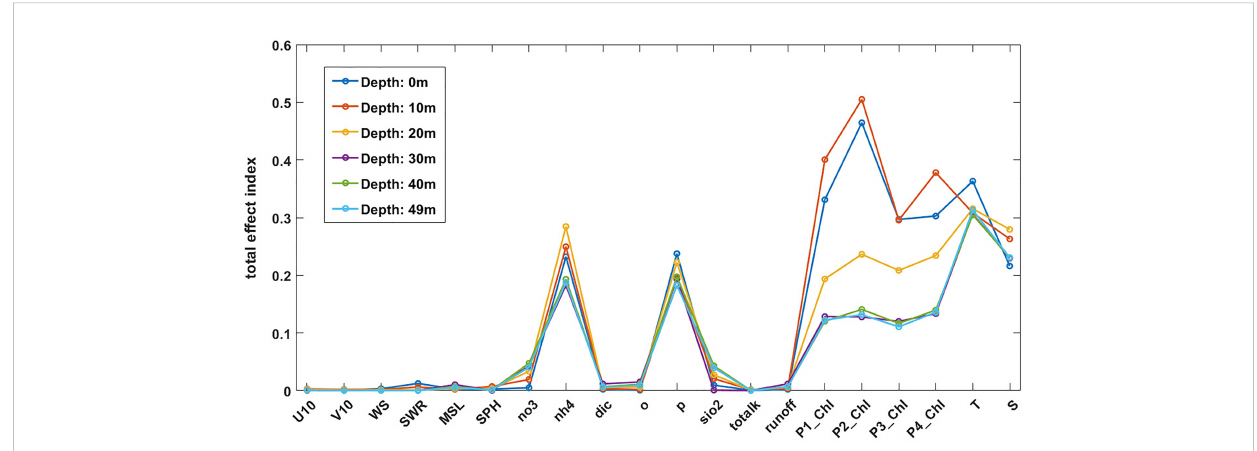
FIGURE 8 Total effect indexes for the full range of ML model inputs from the MinSc case at the L4 location. The abbreviations are: “ U10 ” : zonal wind at 10m, “ V10 ” : meridional wind at 10m, “ WS ” : total wind speed, “ SWR ” : incoming short-wave radiation, “ MSL ” : mean sea level pressure, “ SPH ” : speci fi c humidity, “ no3 ” : riverine nitrate input, “ nh4 ” : riverine ammonium input, “ dic ” : riverine dissolved inorganic carbon input, “ o ” : riverine oxygen input, “ p ” : riverine phosphorus input, “ sio2 ” : riverine silicate input, “ totalk ” : riverine total alkalinity input, “ runoff ” : the freshwater runoff by the river, “ P1_Chl ” : diatoms chlorophyll, “ P2_Chl ” : nanophytoplankton chlorophyll, “ P3_Chl ” : picophytoplankton chlorophyll, “ P4_Chl ” :dino fl aggelates chlorophyll (all on the surface), “ T ” : sea surface temperature, “ S ” : surface salinity. The different lines correspond to the predicted oxygen outputs at different depths (marked in the